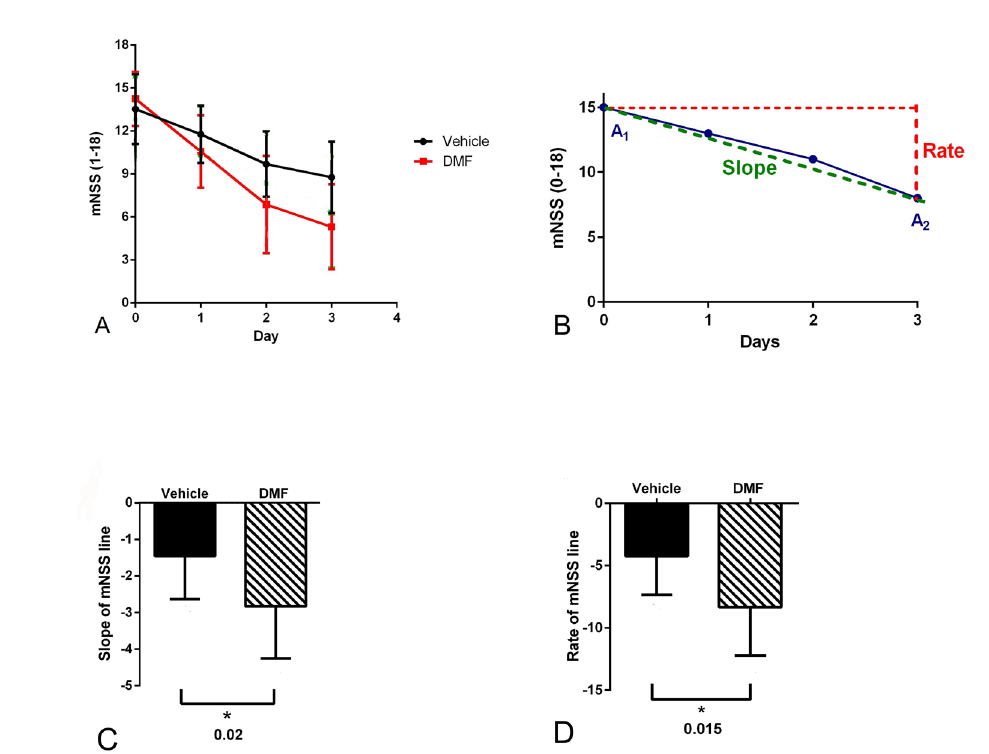
FIGURE 1 - A, The downward line of mNSS in DMF -treated rats with transient brain ischemia are comparable to those of vehicle-treated rats on days 0, 1, 2 and 3 post-ischemia-reperfusion injury; B, the improvement of neurobehavioral function was evaluated using two indices: slope and rate.; C, D significant neurobehavioral improvement in mNSS scores was evident in DMF treatment as compared to vehicle after three days post-ischemia–reperfusion injury (*P<0.05 ). DMF; dimethyl fumarate, mNSS, modified neurological severity